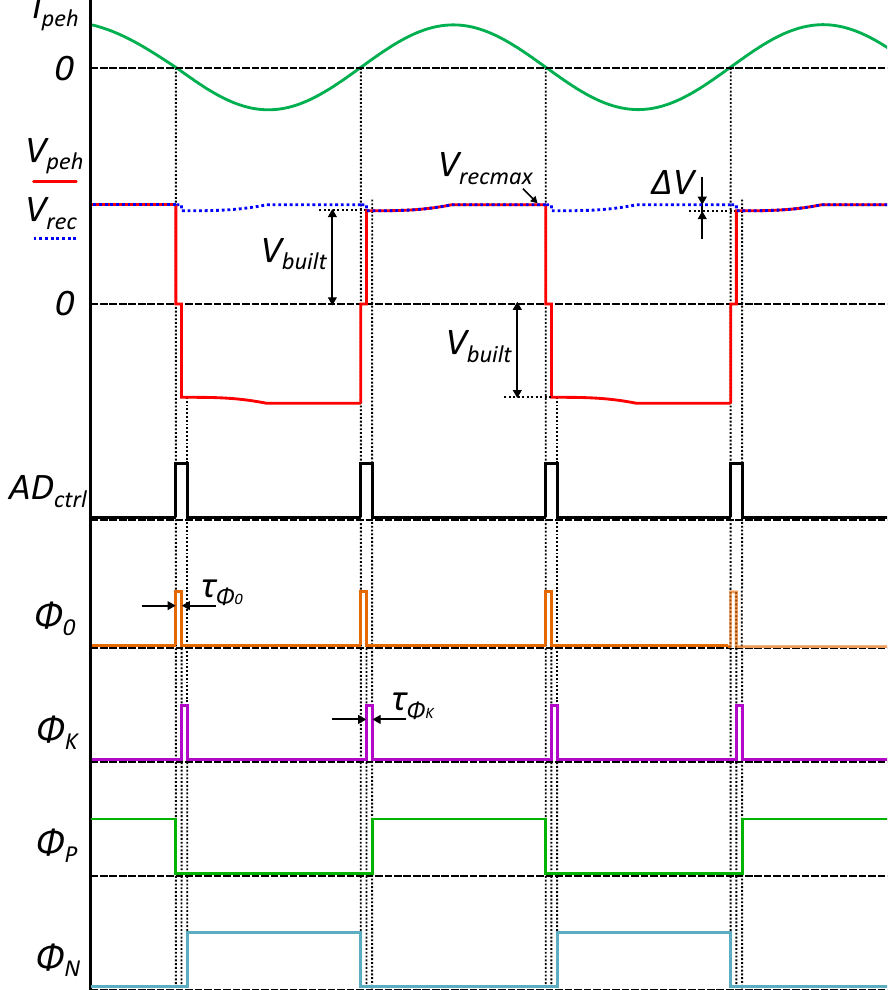
Figure 4. Voltage and current waveforms of PEH, and control